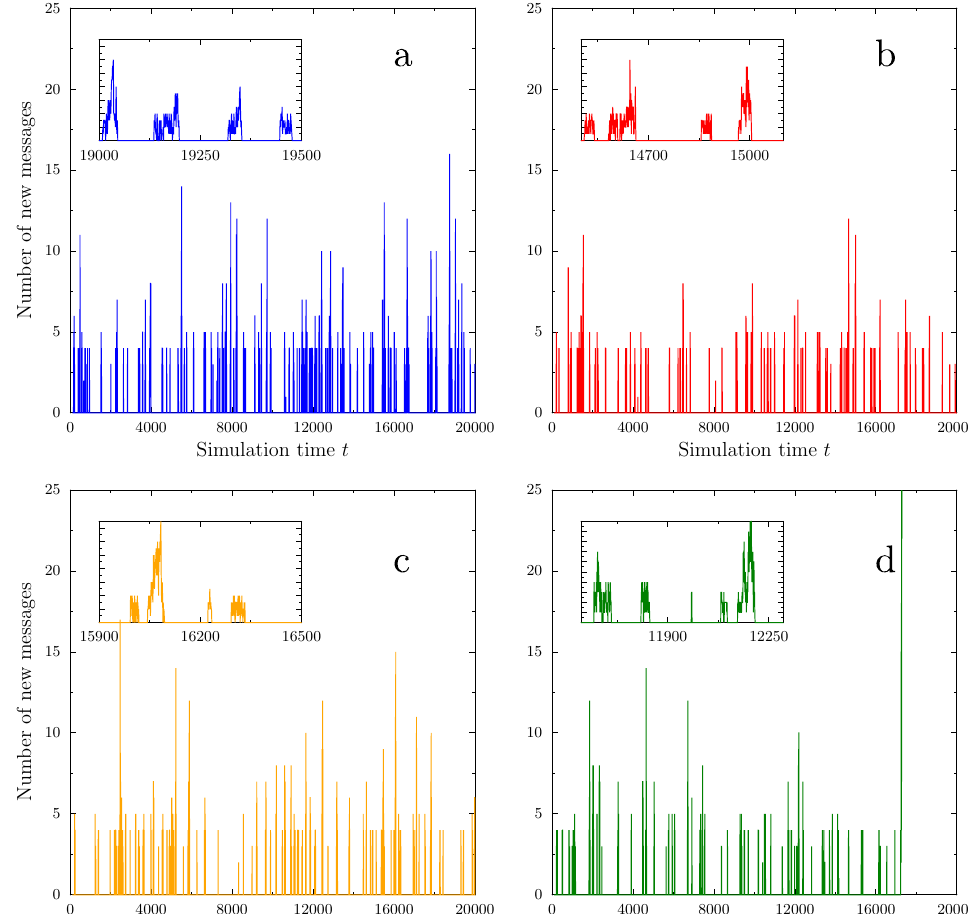
Figure 6. Examples of typical time evolution of the number of new messages written at each time tick of the simulation. The panels correspond to four separate simulation runs, using the same simulation parameters. In all simulations, we observe a series of apparently random spikes in message number. The data exclude messages written by initiators. The insets show close-up views of selected activity spikes. The simulation shown in green ( d ) experiences a transition to a state in which the AV movement triumphs: all agents refrain from vaccination, most of them becoming inflexible activists at transition time t = 17,320. The presence of such transitions to a state where the AV movement triumphs depends on the model parameters (such as A T and P W , here equal to − 1.8 and 0.45, respectively), and the distribution of transition times is close to a power law (Figure